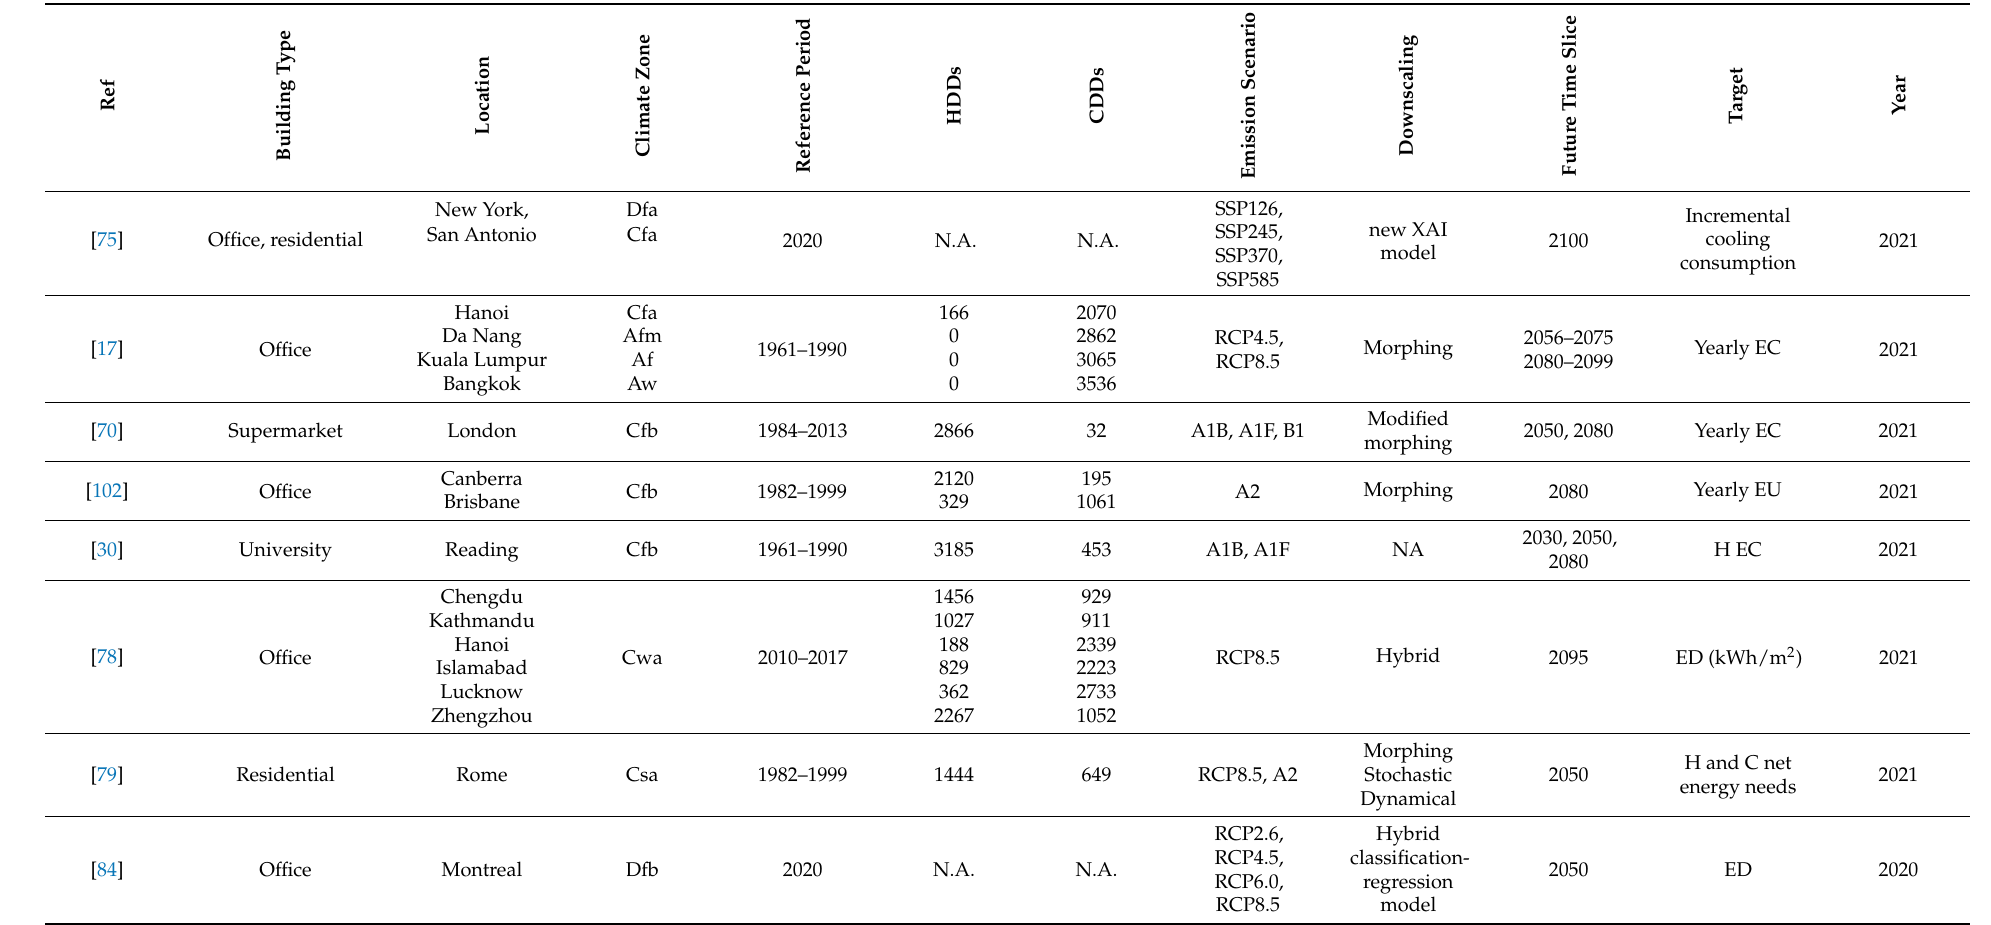
Table A1. List of reviewed studies selected for the quantitative analyses, in order of year of publication. Corresponding building type, location, climate zone, reference period, emission scenario, downscaling technique, future time slice, and target are reported. N.A. stands for “not available”; EC stands for “energy consumption”, EU stands for “energy use”, ED stands for “energy demand”, H stands for “heating”; C stands for